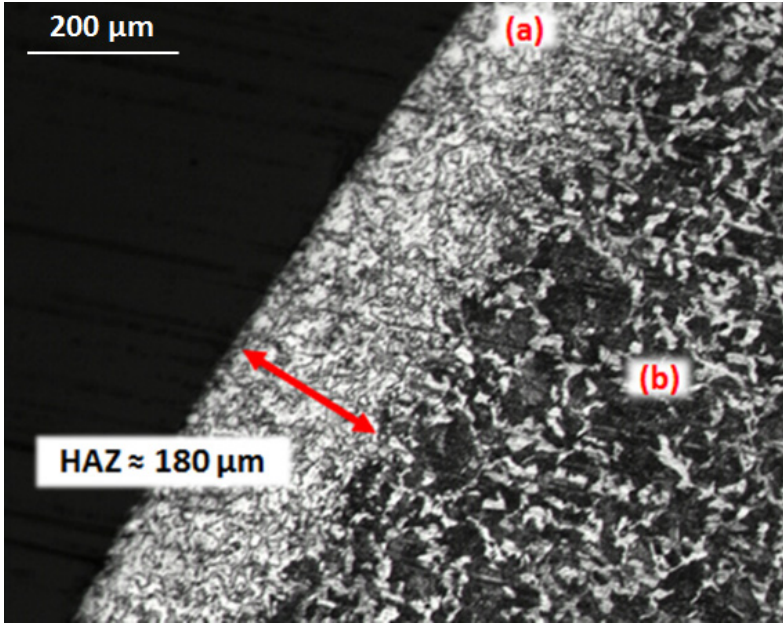
Figure 7. Micrography of a laser hardened cross-section: transition from: ( a ) martensitic structure to ( b ) ferrite and perlite structure (Laser power = 200 W and Scan speed = 20 mm/s).